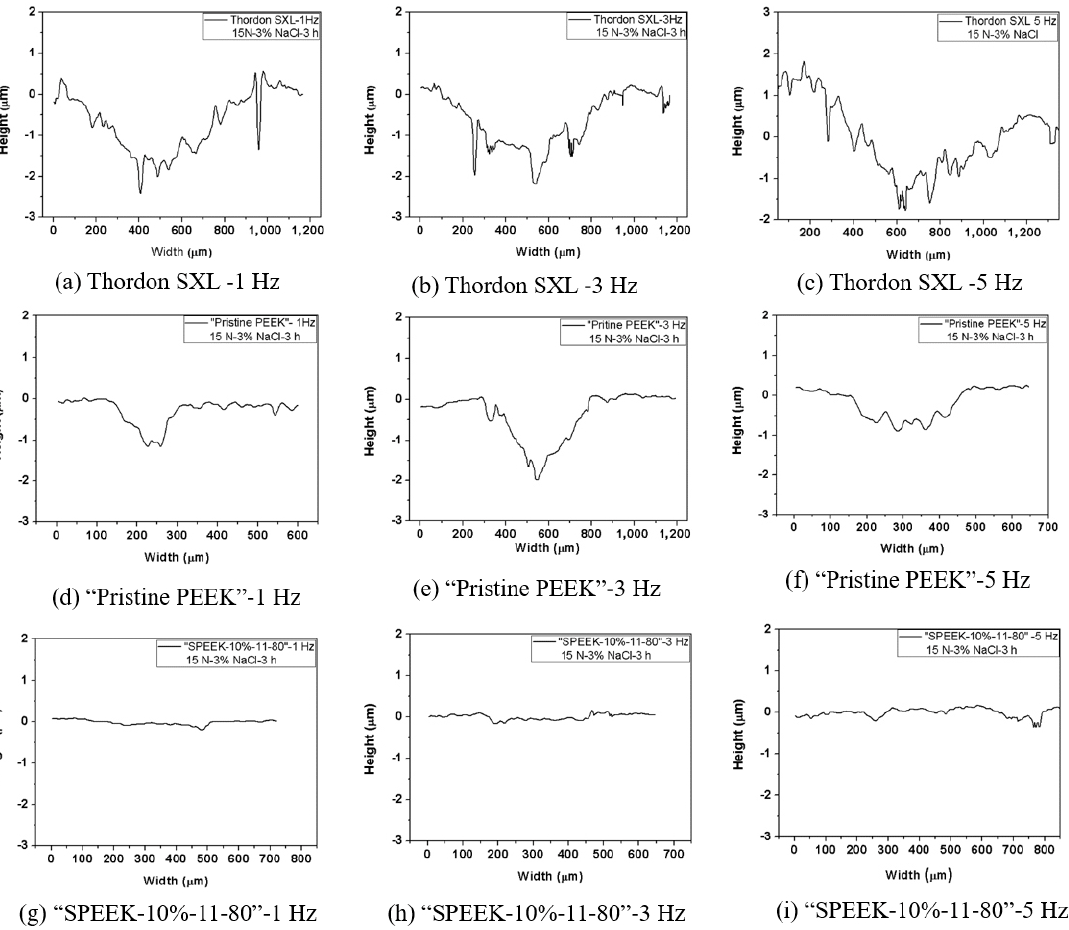
Fig. 6 Cross-section of the wear tracks at 1, 3, and 5 Hz of (a–c) Thordon SXL bearing, (d–f) pristine PEEK, and (g–i) SPEEK-10%-11-80 plastics. The test was performed for 3 h. The average wear rate of the SPEEK-10%-11-80 sample was smaller than those of the Thordon SXL bearing and the pristine PEEK